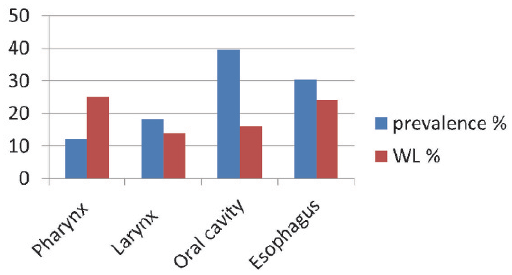
Figure 1 - UADT prevalence and weight